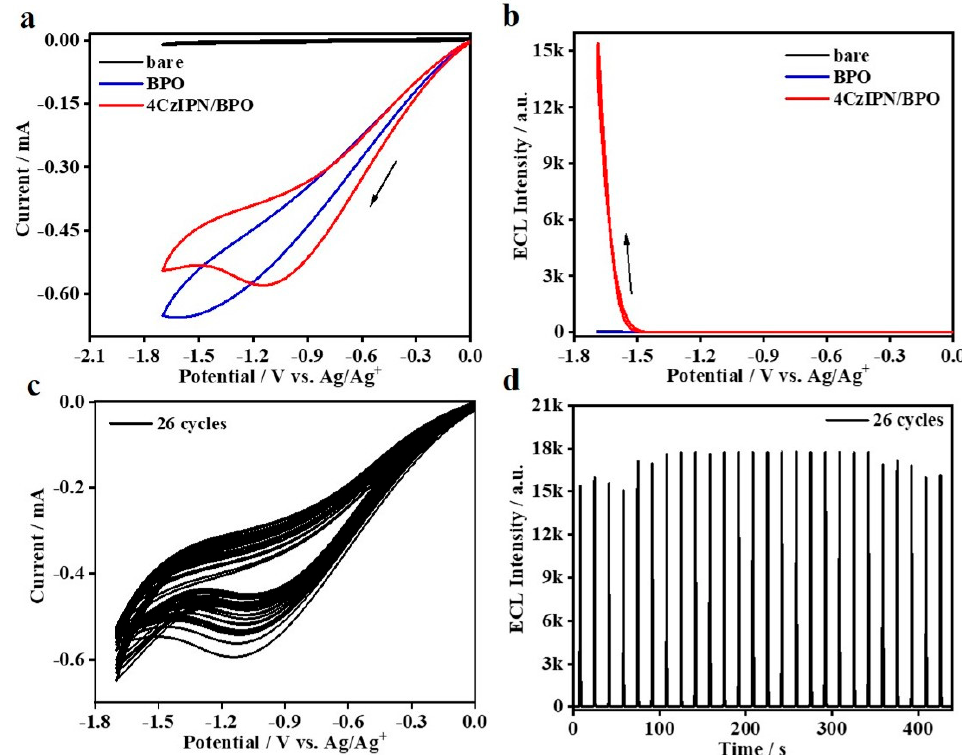
Figure 4. CVs ( a ) and ECL curves ( b ) of bare DCM, bare DCM containing 25 mM BPO, 0.1 mM 4CzIPN containing 25 mM BPO in DCM with 0.1 M TBAPF 6 electrolyte. Stability of CV curves ( c ) and ECL intensity of 4CzIPN/BPO couple under continual scans ( d ).